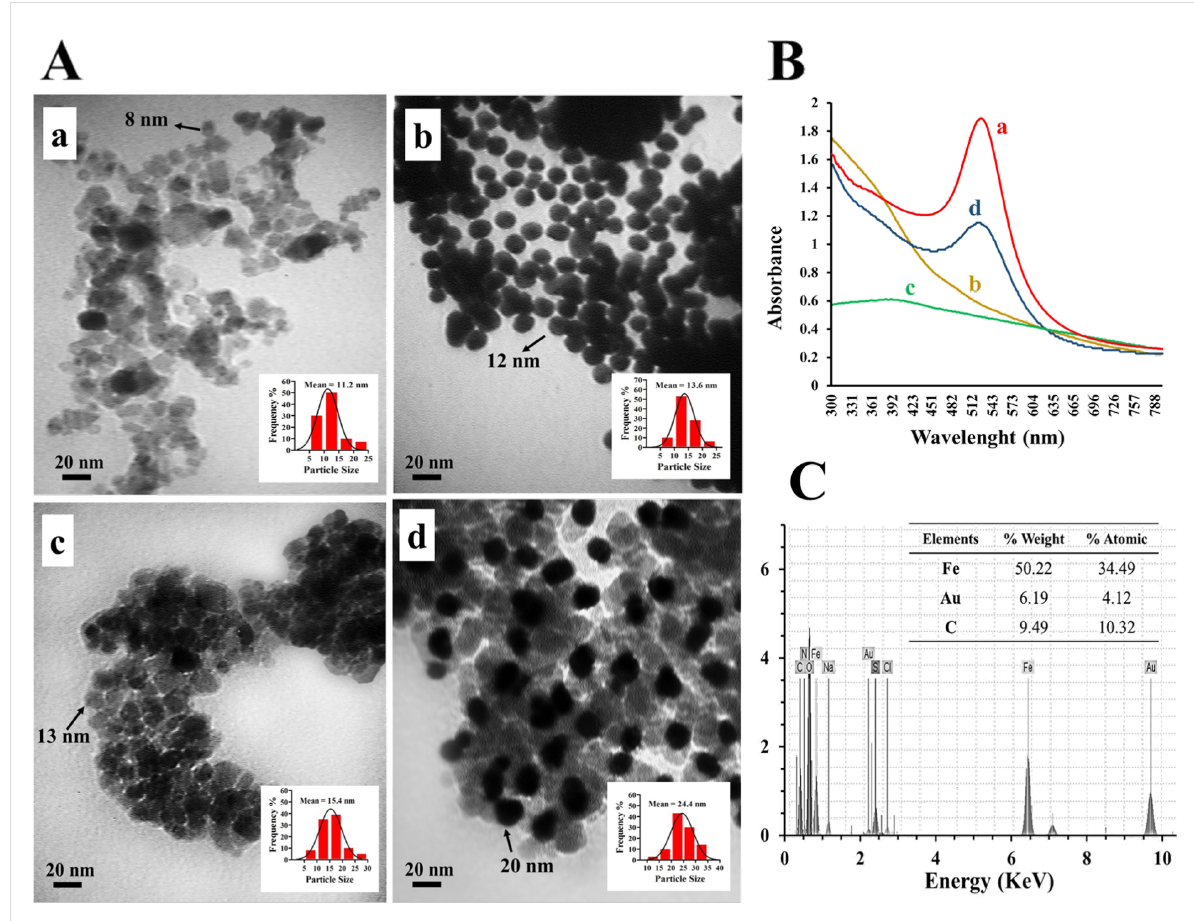
Figure 2: (A) TEM images of synthesized Fe 3 O 4 NPs (a), gold NPs (b), TMC@Fe 3 O 4 NPs (c), and gold–magnetic NPs (d) with their corresponding particle size distribution (inset). (B) UV–vis analysis of gold NPs (a), Fe 3 O 4 NPs (b), TMC@Fe 3 O 4 NPs (c), and gold–magnetic NPs (d). (C) EDXD spectra of gold–magnetic